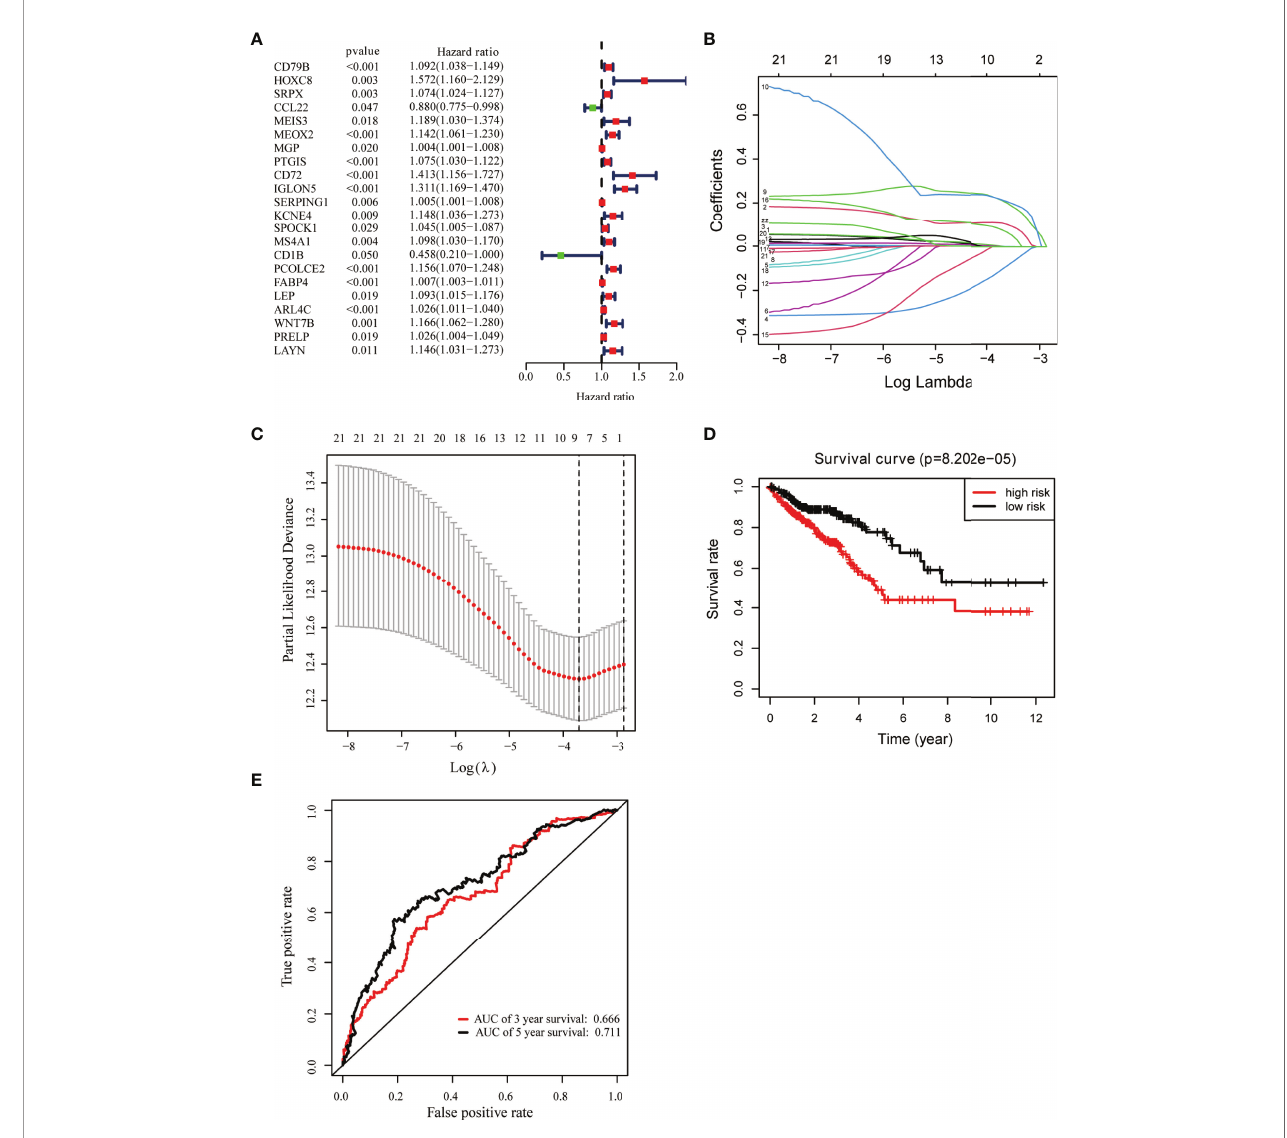
FIGURE 3 | Identi fi cation of key prognostic genes within intersection DEGs. (A) Forest plot of risk genes: Red represented high-risk genes (hazard ratios, HR > 1); green represented low-risk genes (HR < 1). (B) Constructing the LASSO coef fi cient prediction model. (C) Selecting variables in LASSO regression with minimum criteria by 1,000 times cross-validation. (D) Overall survival between high- and low-risk score groups. (E) ROC curves for predicting 3- and 5-year overall survival probability with the nine-gene